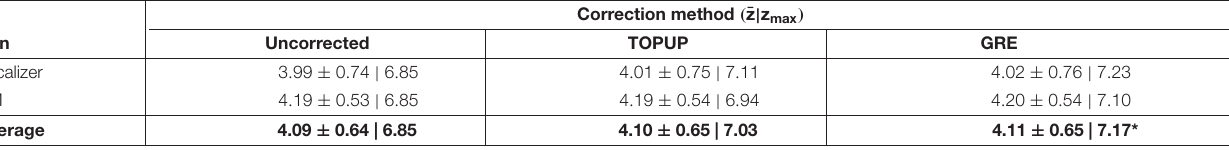
FIGURE 7 | Group activation maps for the localizer (top) and the biological motion (bottom) runs, from uncorrected, TOPUP corrected and GRE-corrected fMRI data. TABLE 7 | Average ( ¯ z ) and maximum ( z max ) Z-score values of the group activation maps for the localizer and biological motion runs. The overall average across runs is also